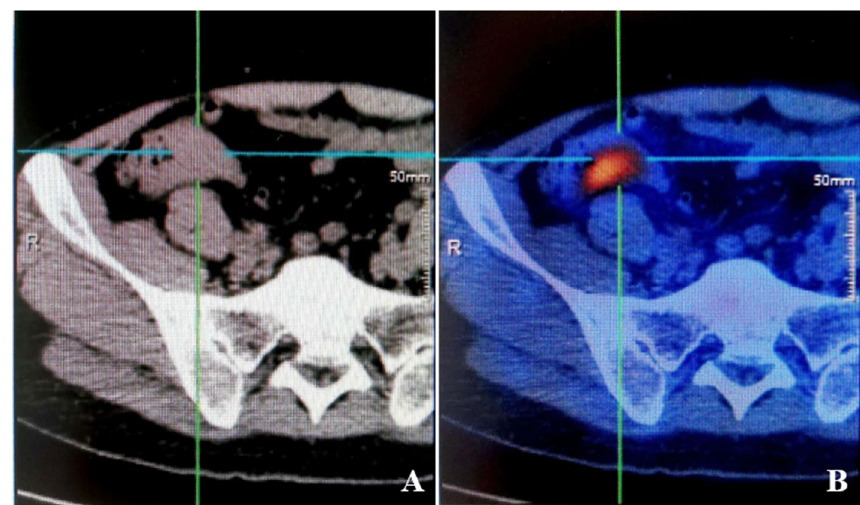
Fig. 4 PET/CT findings. A Focal thickening of the cecum wall, about 13 mm. B Increased FDG uptake of the